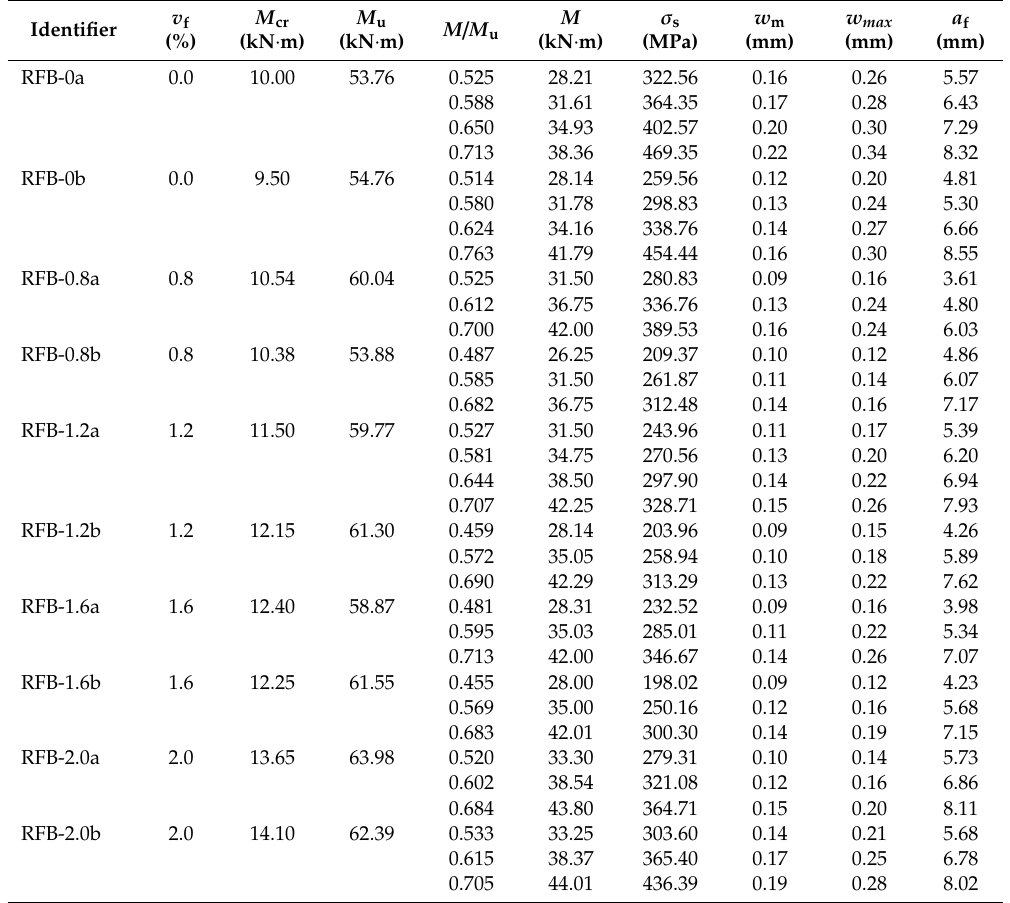
Table 3. Main tested data of the cracking moment, ultimate moment, and the normal serviceable